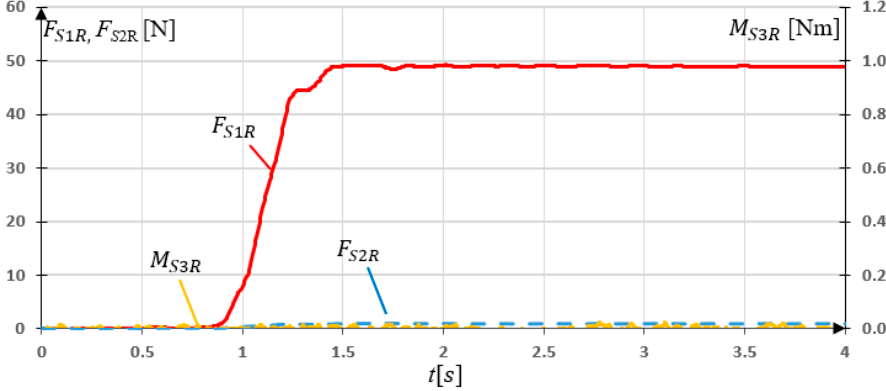
Figure 15. Experimental research results for the grip loaded with 5 kg mass in y direction.